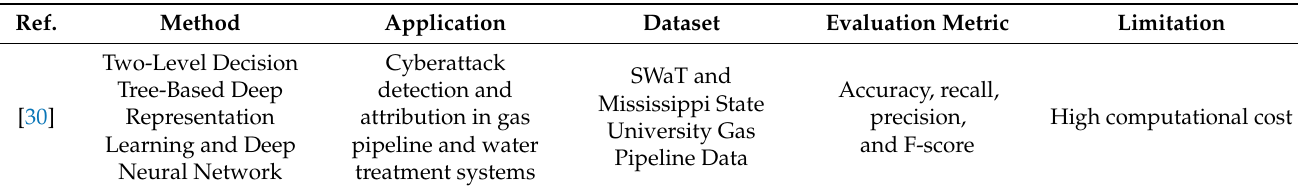
Table 2. A summary of deep learning methods of cyberattack detection.